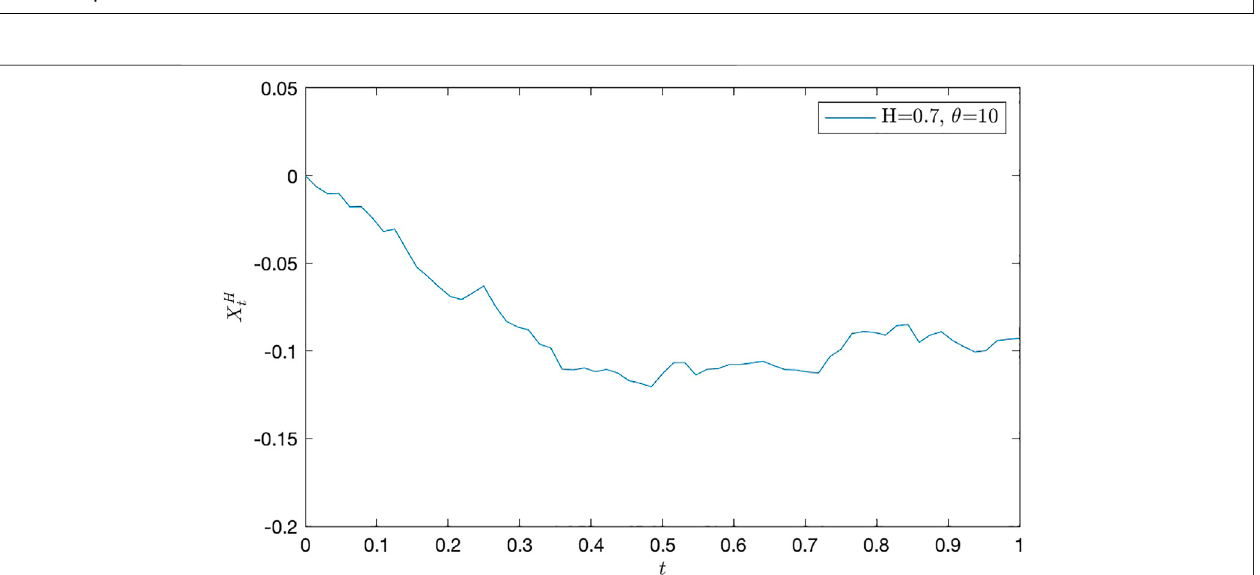
FIGURE 2 | Path of X H with θ (cid:1) 10 and H (cid:1) 0.7.